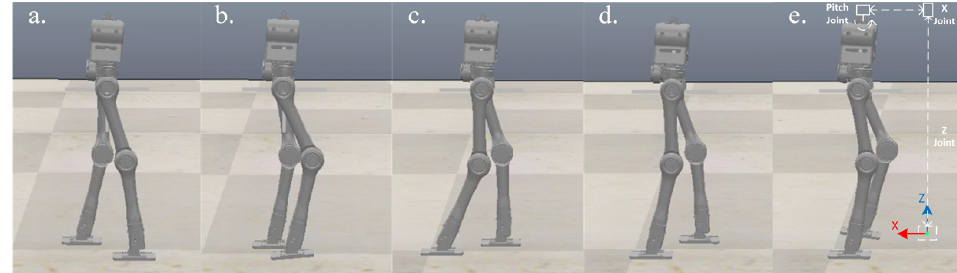
Figure 6. The planned joint position trajectory and the feedback trajectory from simulation. The tracking performance of flat walking simulation is shown from ( a – f ). The target position trajectories is represented in blue and real trajectories in red.